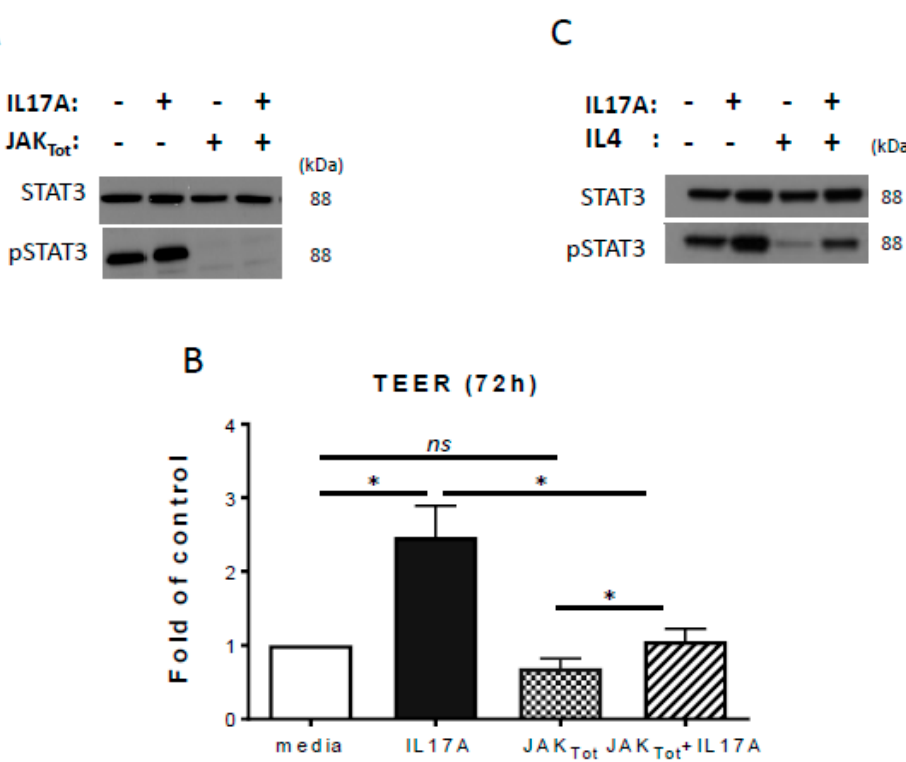
Figure 3. A pan-JAK inhibitor blocks IL-17A-induced TEER enhancement. ( A ) A representative Western blot demonstrates that pan-JAK inhibition blocks STAT3 activation (pSTAT3; EP2147Y), but has no effect on total STAT3 expression (STAAD22A) ( B ) Pretreatment with a pan-JAK inhibitor (JAKtot: 10 μ M; n = 4) inhibited IL-17A (100 ng/mL) induced TEER in primary human keratinocytes. ( C ) IL-4 blocked STAT3 phosphorylation in PHK treated with IL-17A or media alone. Representative Western blot bands of n = 3 experiments are shown. All data are shown as mean ± SEM fold of control. * p ≤ 0.05, ns: not significant.